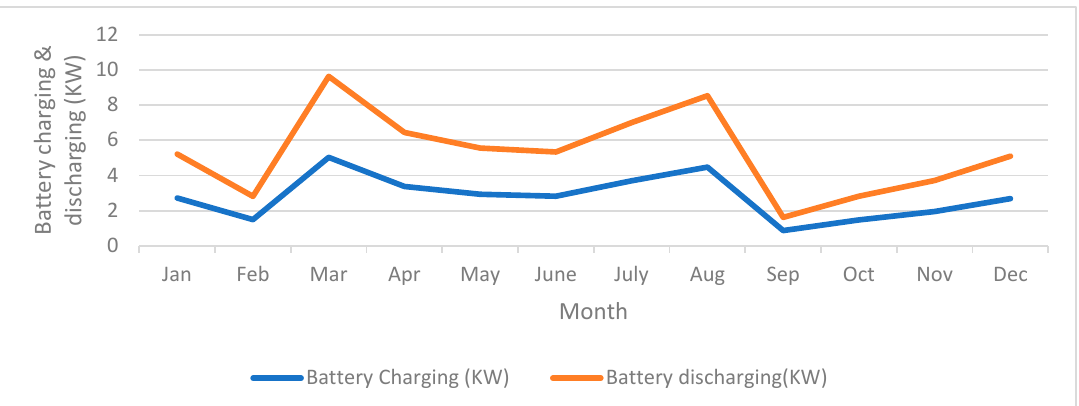
Figure 7. Monthly Li-ion charge and discharge power.